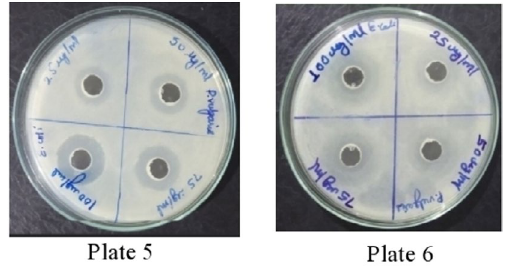
Fig. 7. Plate 7 & 8. Anti-Bacterial Activity of Methanolic Extract of P. vulgaris against B. subtilis